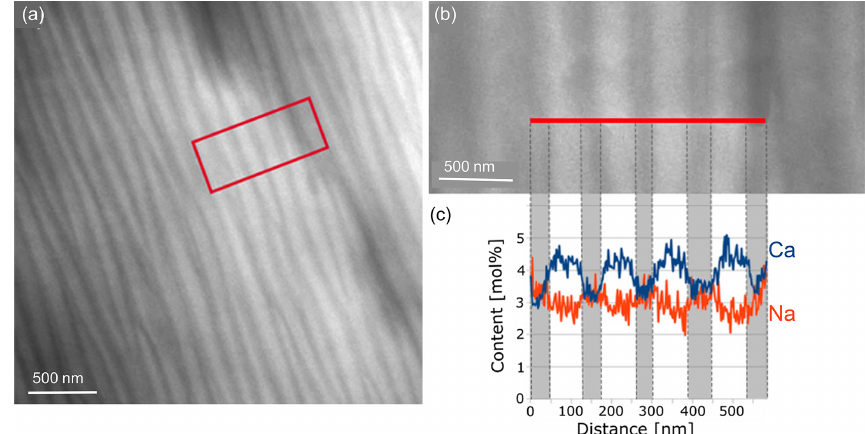
Figure 7. STEM dark-field image (a) of the lamellae of labradorite in zone [001] in a part of the matrix. The area framed in red is enlarged in (b) , where the red line marks the position of the line scan. (c) Measurements of the Na and Ca content (in mol%) plotted against the distance in